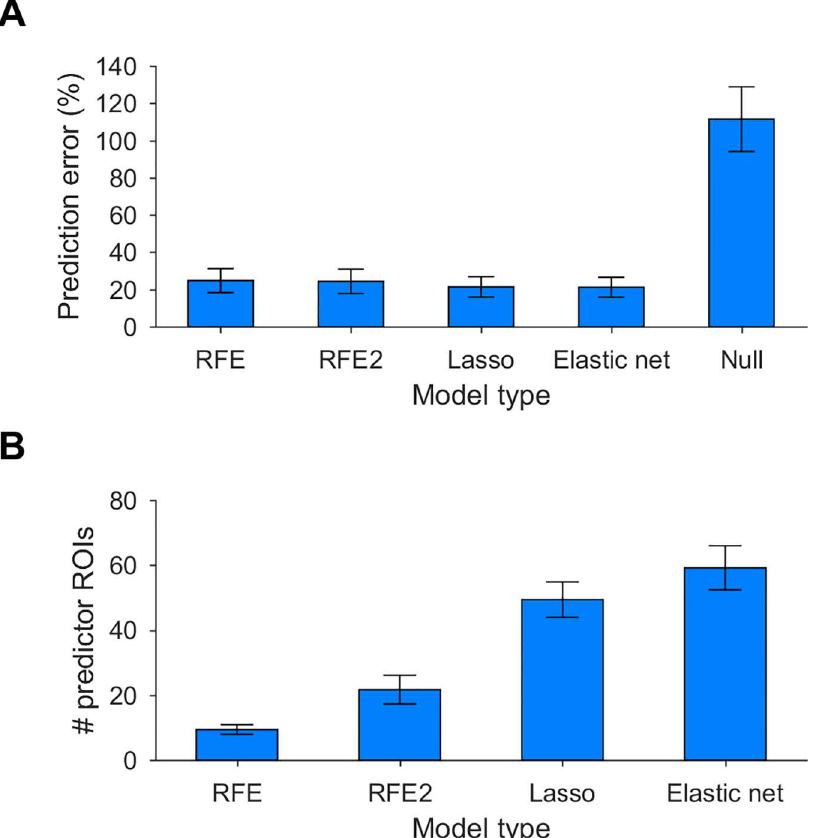
Fig 2. RFE models perform similarly to Lasso and elastic net models, but with fewer predictor ROIs. A. The averagepredictionerror (across ROIs and n = 46 subjects) of models generatedusing RFE, RFE2, Lasso or elastic net was similar (average difference < 3% of activity variance), and significantly smaller than null models (averagedifference ~ 90%). Statistics reflect 108/112cortical ROIs (excluding temporal pole and entorhinalcortex that had large prediction error in all models). B. The averagenumberof predictor ROIs selectedby RFE models was significantly smaller than that selectedby RFE2, Lasso or elastic net